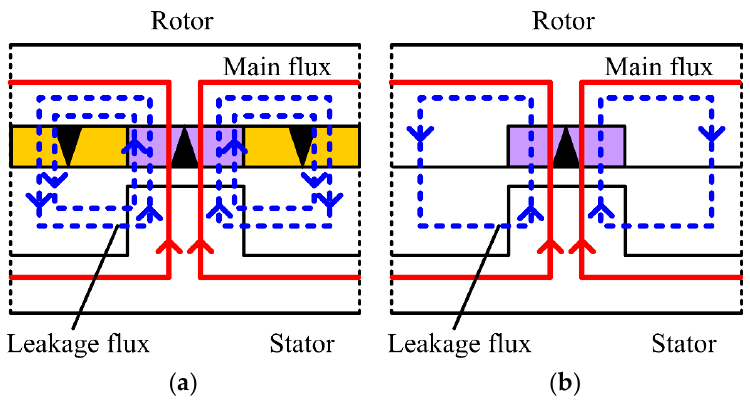
Figure 2. Fluxes flow patterns: ( a ) OR-VPM; ( b ) OR-CP-VPM.